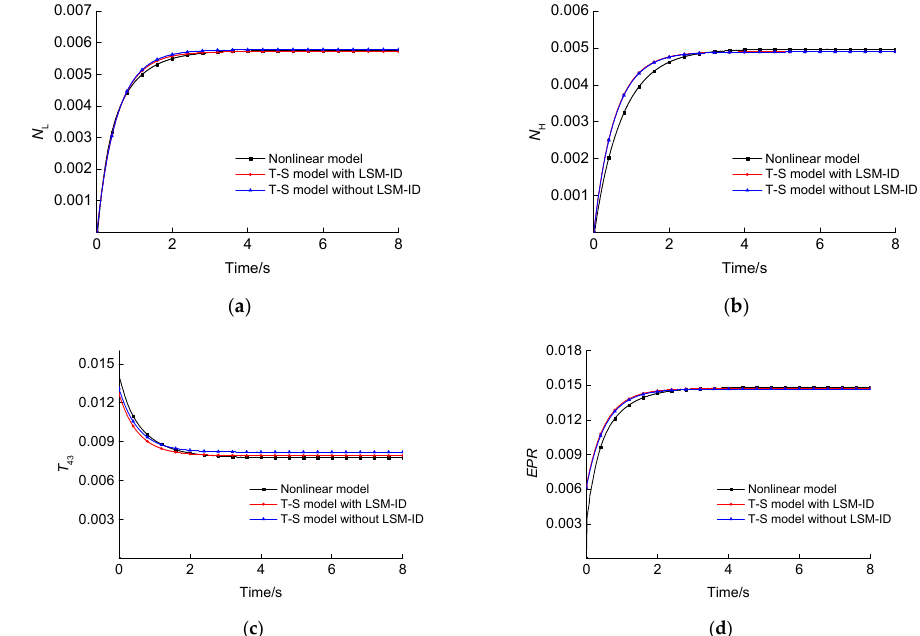
Figure 10. Responses under 10.5 km and 1.22 Mach. ( a ) N L response comparison. ( b ) N H responses. ( c ) T 43 responses. ( d ) EPR responses.